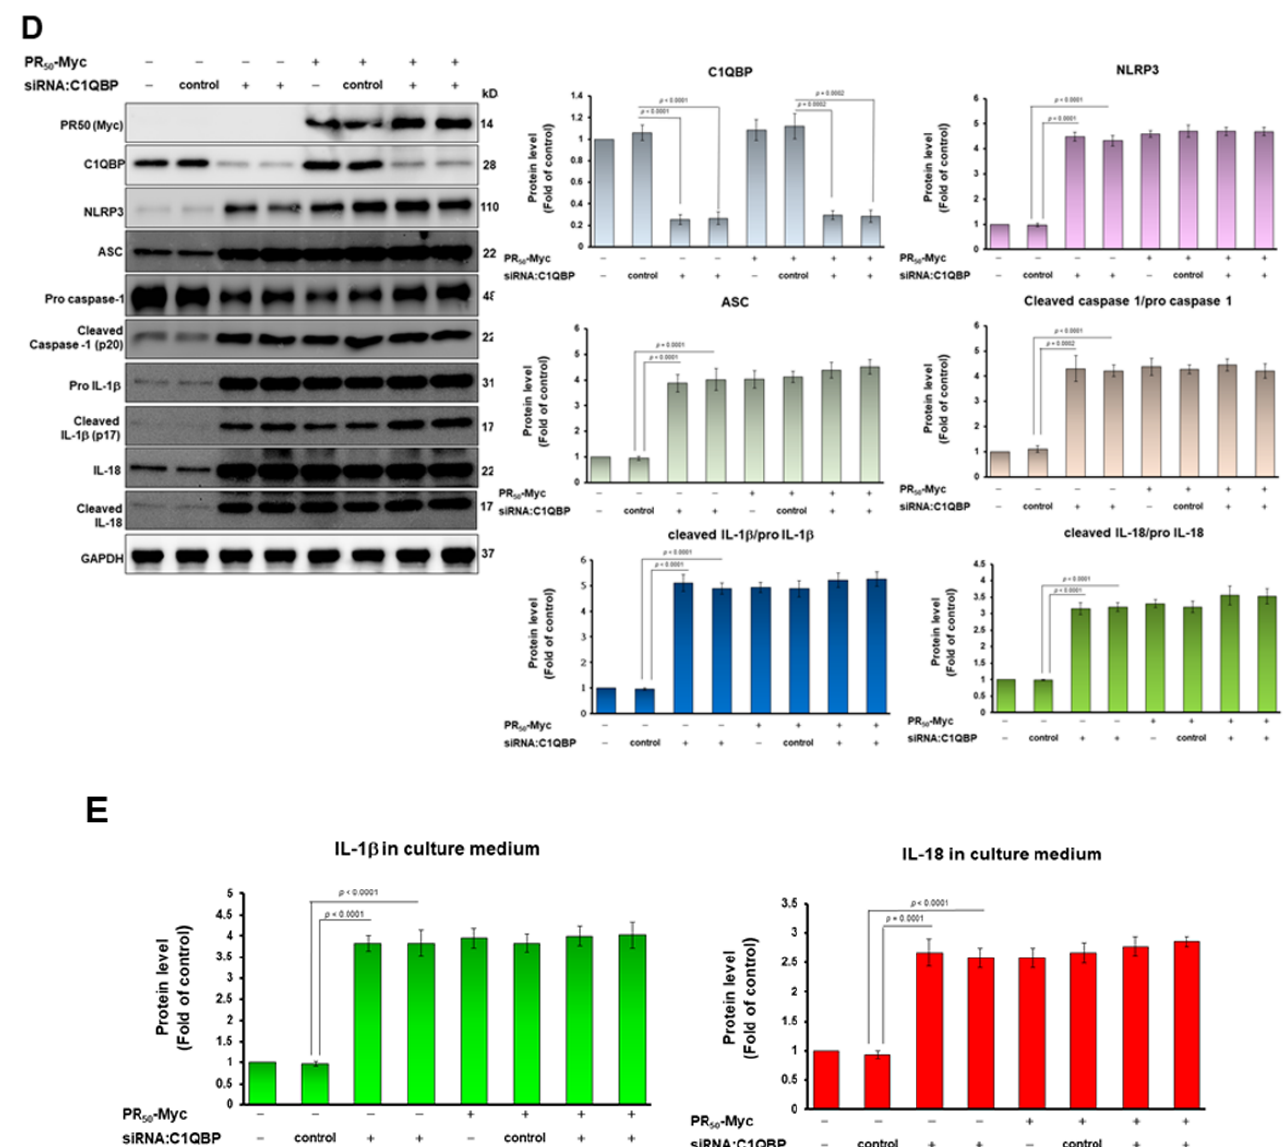
Figure 7. Knockdown of C1QBP directly caused NLRP3 inflammasome activation in HMC3 cells and covered the effect of PR 50 on NLRP3 inflammasome activation. Control or PR 50 -expressing HMC3 cells were down-regulated the expression of C1QBP by RNAi for 24 h. ( A ) Immunofluorescence staining of NF- κ Bp65 (red) and Myc-tag (green). Knockdown of C1QBP promotes the movement of NF- κ B p65 from the cytoplasm to the nucleus. DAPI was used for nuclear staining. ( B ) Extract of cell nucleus was analyzed for the level of NF- κ B p65 by Western blotting. TBP was used as a loading control. The bottom panel shows quantitative analysis graphs using ImageJ software. ( C ) NF- κ B p65 transcription factor activity assay showed that Knockdown of C1QBP promotes NF- κ B activity. TBP was used as a loading control for input. ( D ) Cell lysates were analyzed for the expression of PR 50 , C1QBP, and NLRP3 inflammasome-related components by Western blotting. GAPDH was used as an internal loading control. The left panel is a representative set of images. The right panel shows a graph of quantitative analysis using ImageJ software. ( E ) The level of mature IL-1 β and mature IL-18 in the conditional medium was measured by